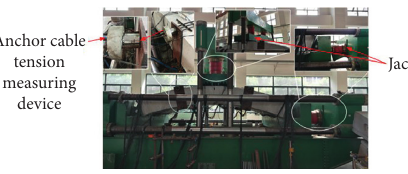
Figure 4: Test device.